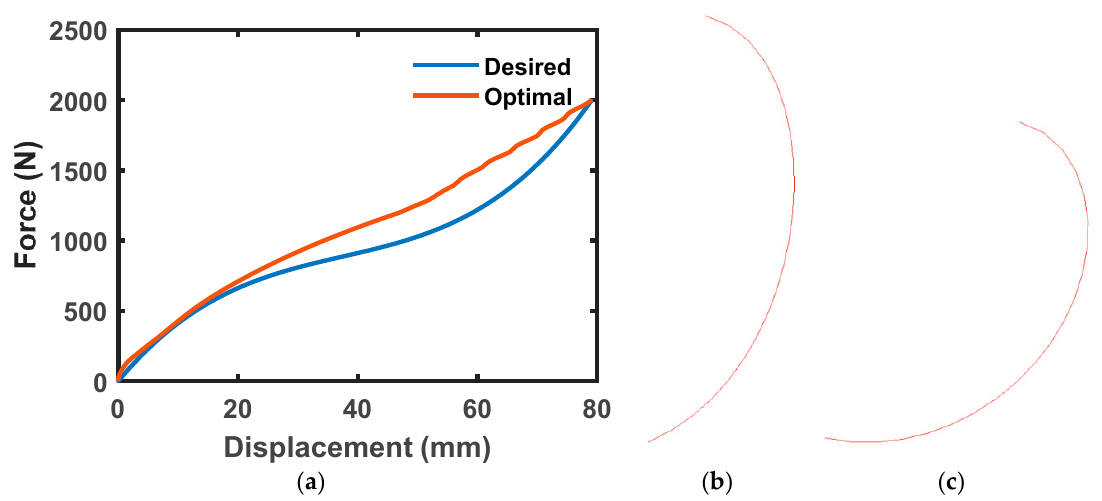
Figure 6. ( a ) Force-displacement characteristics of the prosthesis with stepy characteristics. ( b ) Initial shape of the optimized prosthesis with stepy characteristics. ( c ) Deformed shape of the optimized prosthesis with stepy characteristics under force 2000 N.